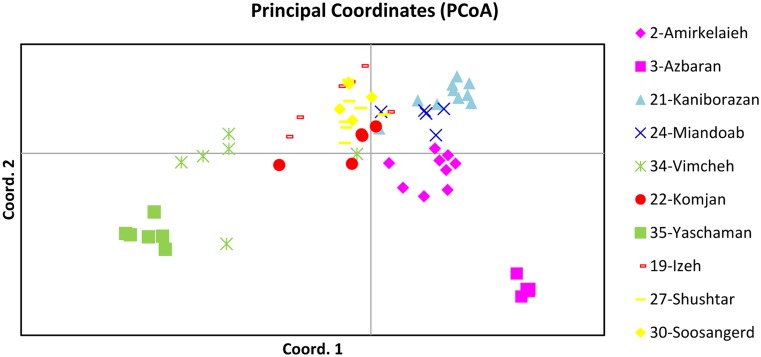
PCoA of 10 populations from each major region.